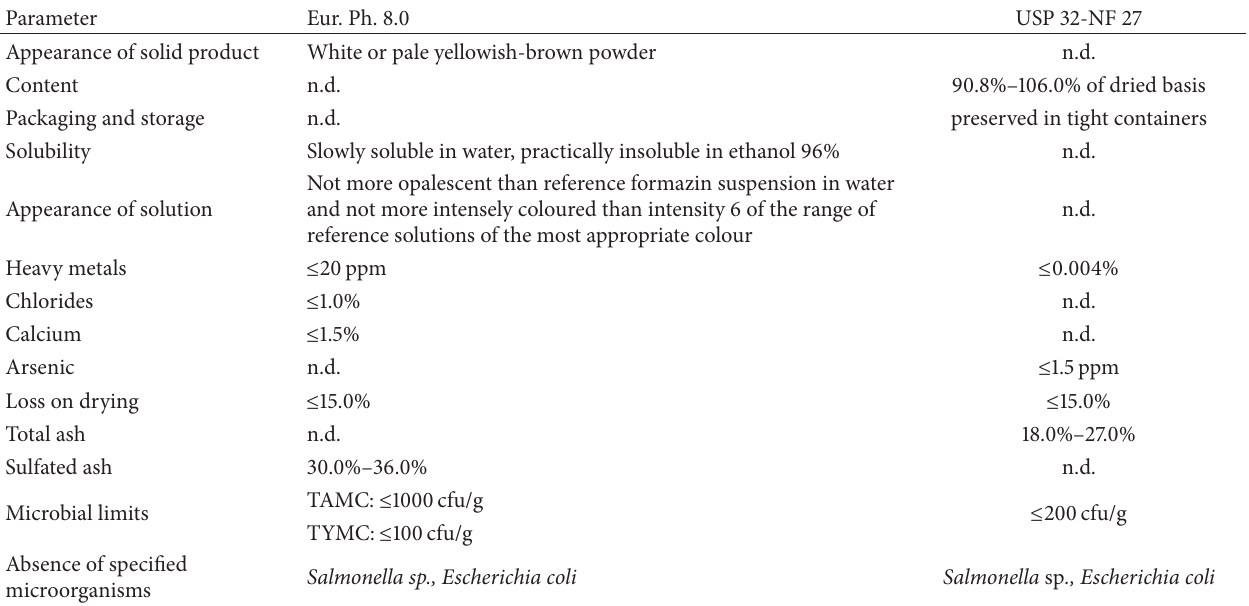
Table 1: Sodium alginate characteristic recommended by the European Pharmacopeia (Eur. Ph.) and United States Pharmacopeia (USP) [5, 6].